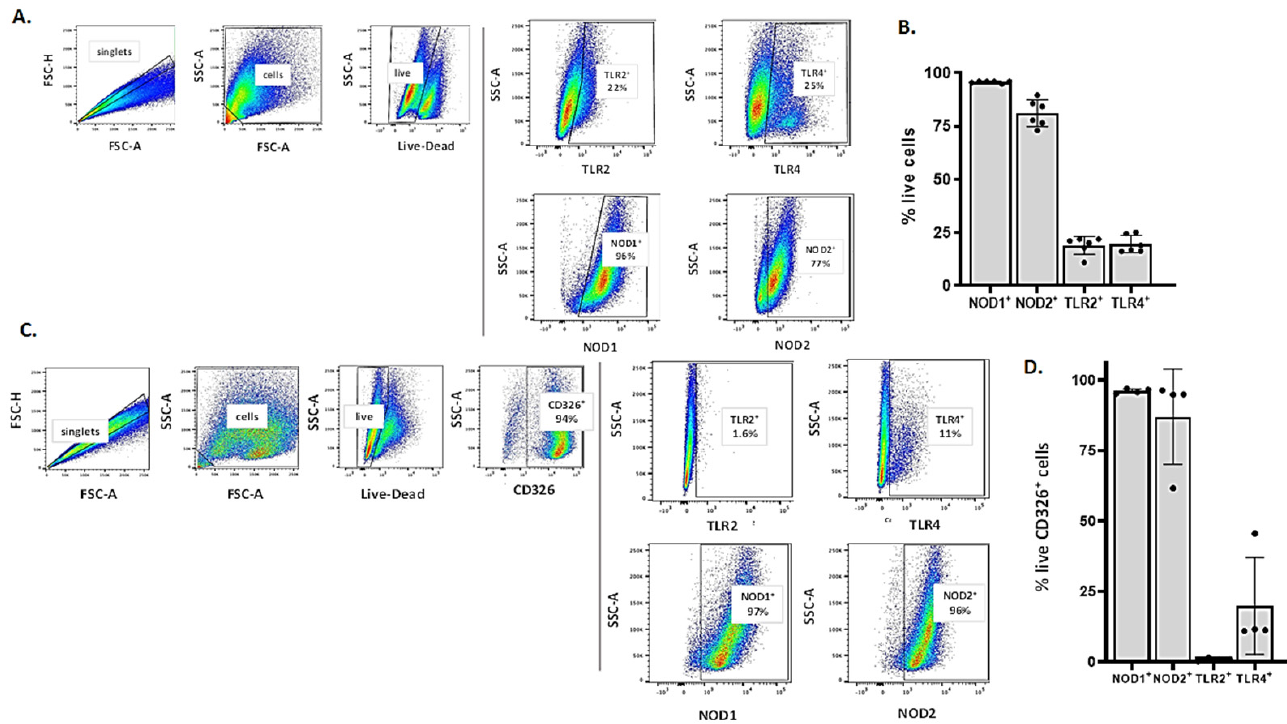
Figure 3. Detection of critical pattern recognition receptors (PRRs) in MLE-12 cells and mTECs by flow cytometry. ( A ) Strategy used to detect TLR2, TLR4, NOD1, and NOD2 expression in MLE-12 cells. ( B ) Quantitative analysis of PRR expression as % live cells. ( C ) Strategy used to detect the expression of TLR2, TLR4, NOD1, and NOD2 in CD326 + mTECs. ( D ) Quantitative analysis of PRR expression as % live CD326 + cells.